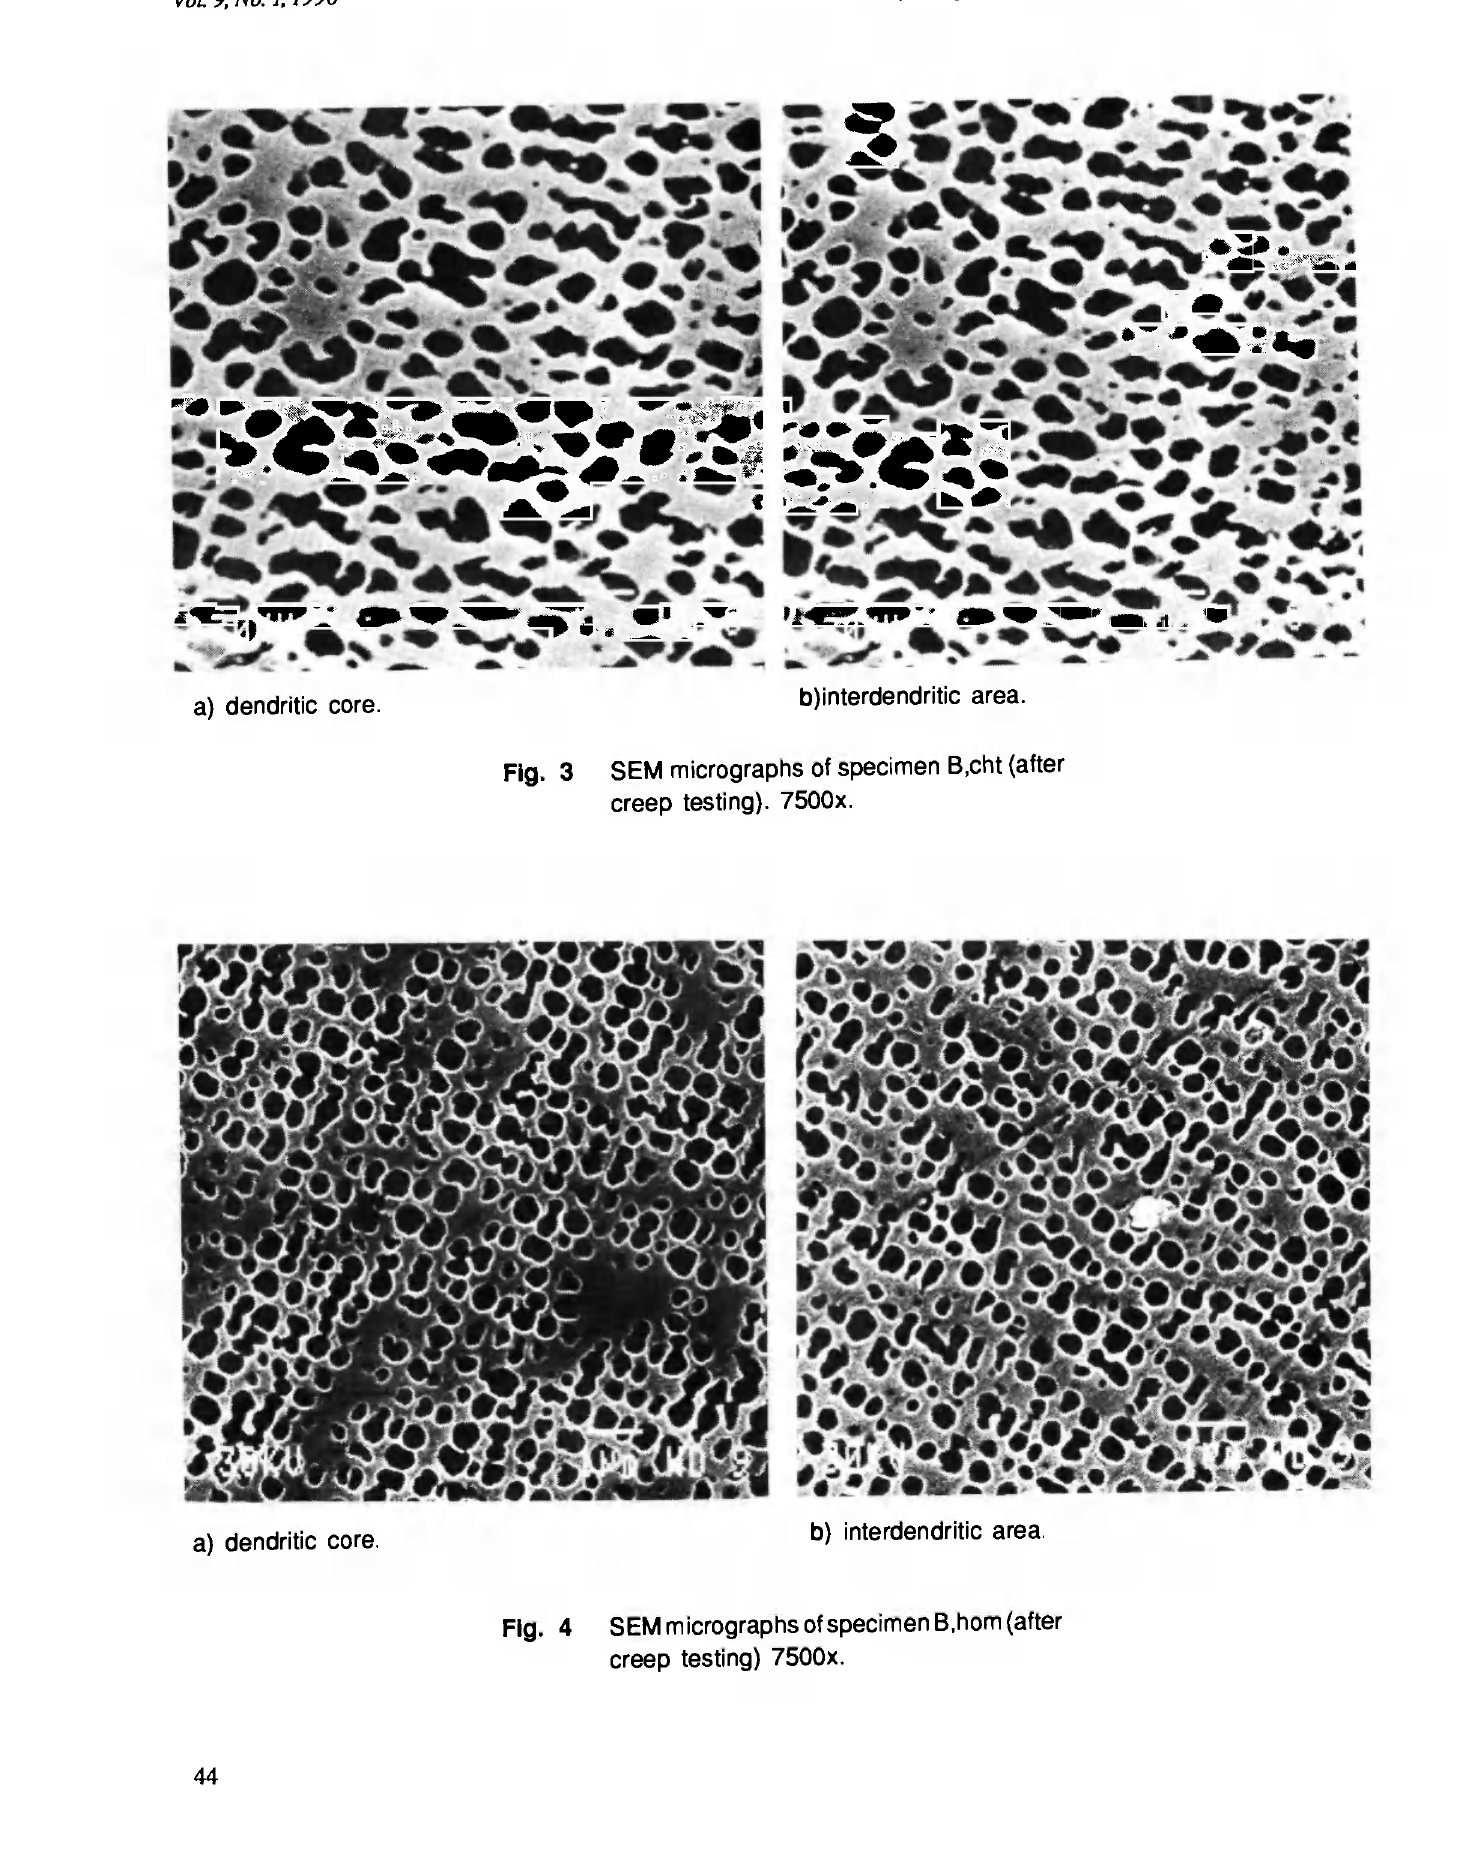
Fig. 4 SEM micrographs of specimen B, hom (after creep testing)